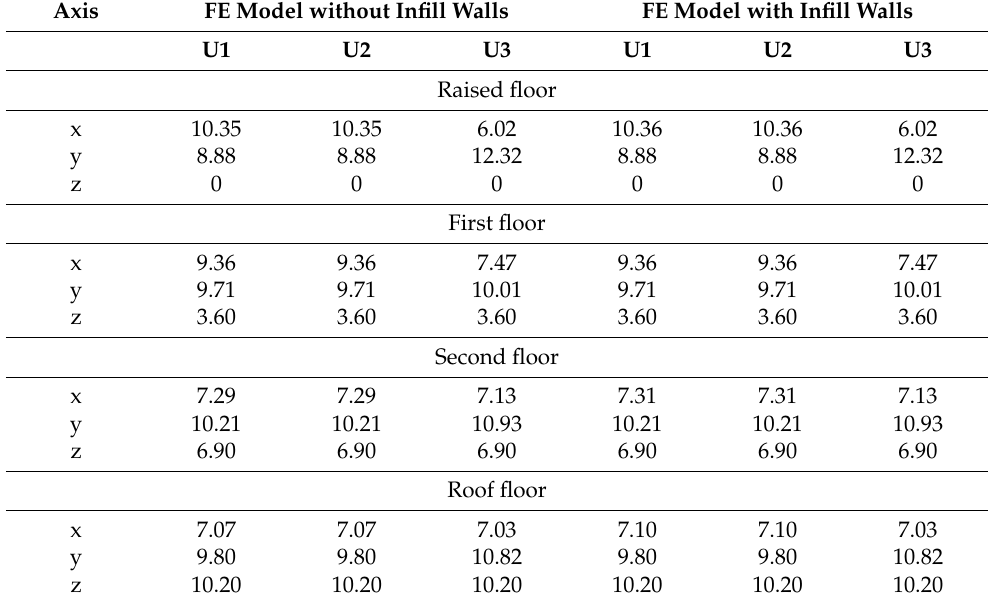
Table 6. Center of Mass coordinates of the two FE Model for each floor. Axis FE Model without Infill Walls FE Model with Infill Walls U1